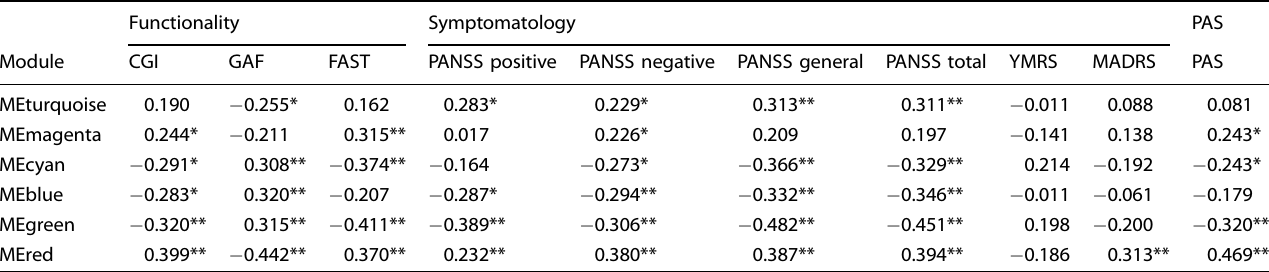
Table 2. Correlation coef fi cients between the module eigenvalues and clinical variables of the six modules showing signi fi cant correlations after multiple testing corrections ( p < 0.007).